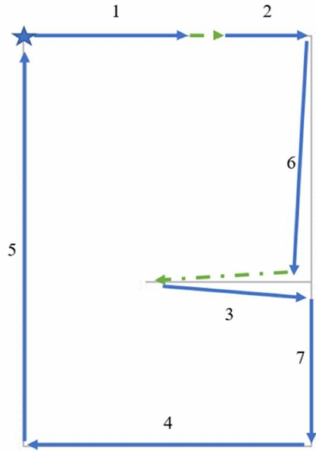
Figure 7. Example 1: seven-wall flat. The first R and D solutions are with T =